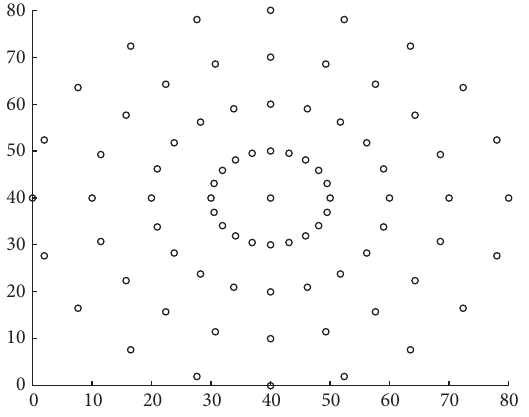
Figure 12: WSN topology in circles; sink node is at the center.